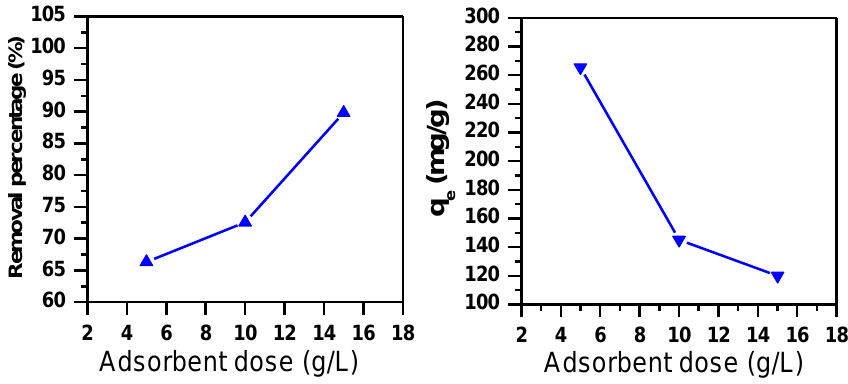
Figure 5. Effect of adsorbent dose on the removal efficiency of MB using MNS-4 (C i = 2000 ppm, contact time = 30 min, pH = 11).